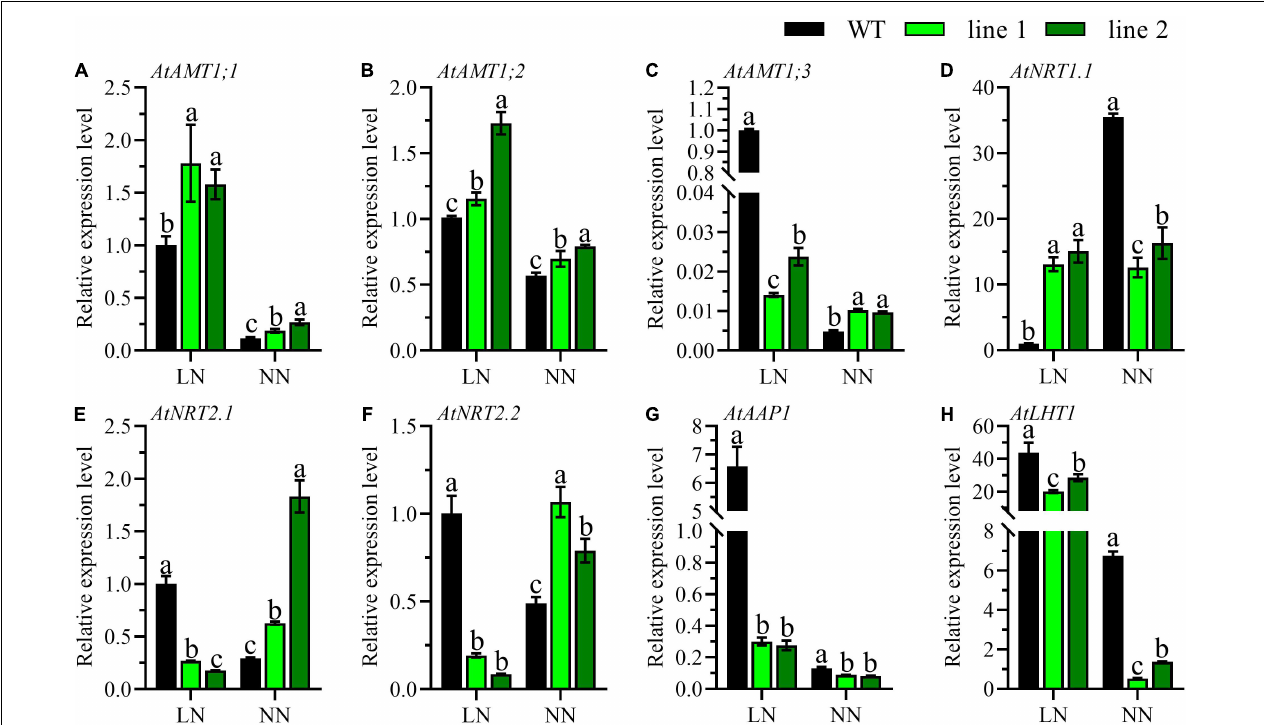
FIGURE 4 | Comparable expression analysis of genes associated with N uptake and assimilation in the roots of two transgenic Arabidopsis lines and wild type. (A–C) Genes related with ammonium-N acquisition, (D–F) genes related with nitrate-N uptake, and (G,H) genes related with amino-N metabolism. Plants were hydroponically cultured for 3 weeks under NN, and then under LN and NN for 2 weeks ( n ≥ 3). AMT , Ammonium transporter; NRT , Nitrate transporter; AAP , Amino acid permease; LHT , Lysine histidine transporter. AtGAPDH was used as the internal control. The expression level in young leaves of WT under LN was set as “1” for AtAAP1 and AtLHT1 , while for the rest genes, the expression level in roots of WT under LN was set as “1.” Three technical replicates were performed. Data are means ± SD . Significant differences are indicated by letters (ANOVA; P ≤ 0.05). WT, wild type (Col-0), line 1 and line 2, two transgenic lines. LN, low nitrogen, 0.25 mM N (0.125 mM NH 4 NO 3 ); NN, normal nitrogen, 5 mM N (2.5 mM NH 4 NO 3